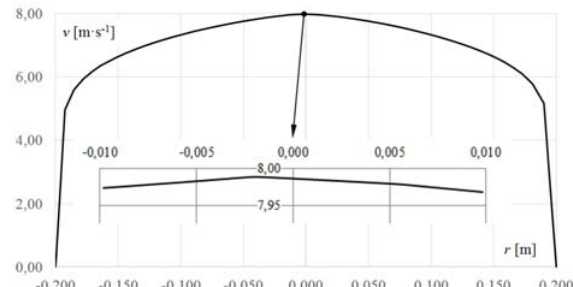
Fig. 2 . Numerical solution in ANSYS-FLUENT